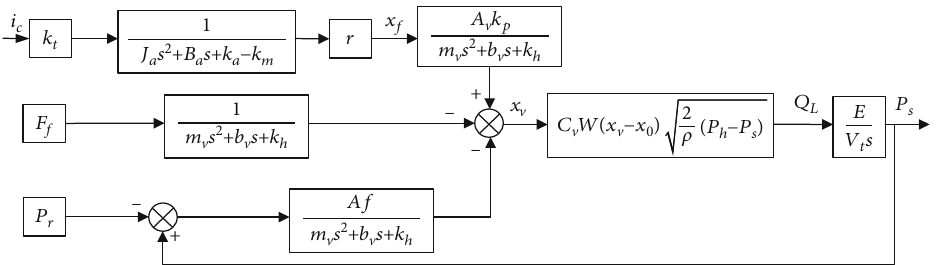
Figure 2: The dynamic characteristic block diagram of the de fl ector jet pressure valve.